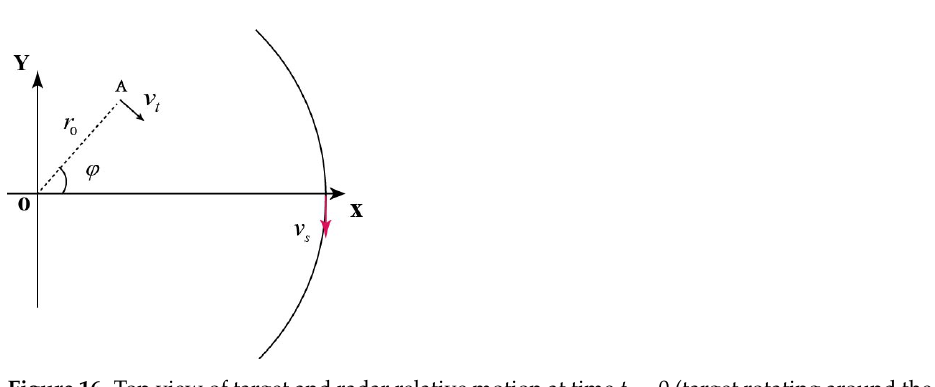
Figure 16. Top view of target and radar relative motion at time t = 0 (target rotating around the scene center with constant